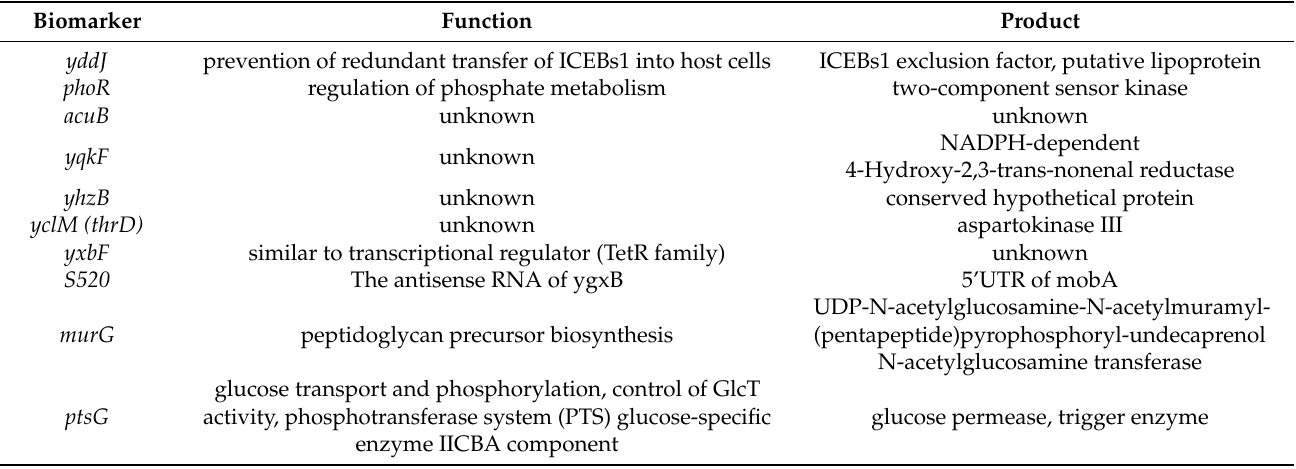
Table 1. Biomarker